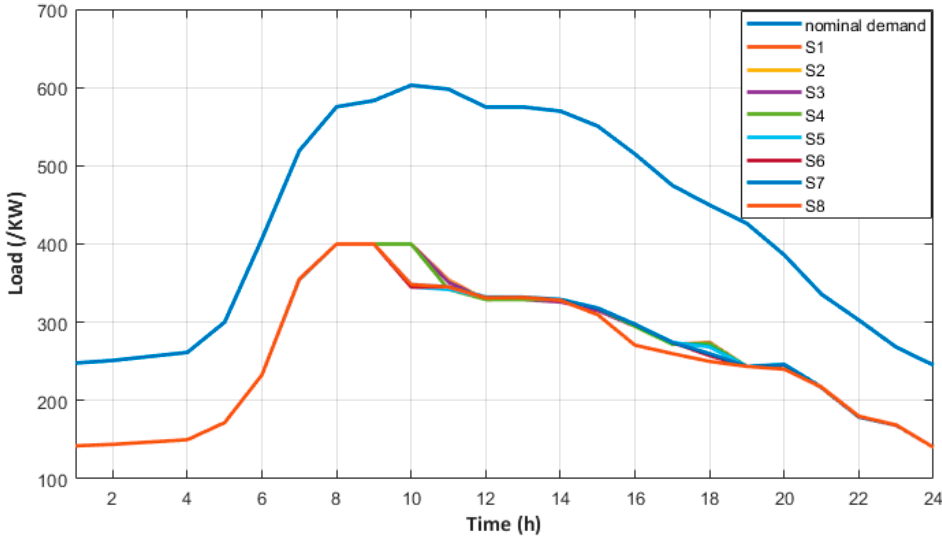
Figure 9. Nominal demand and demand per scenario for 25 April 2019. (source: Authors).